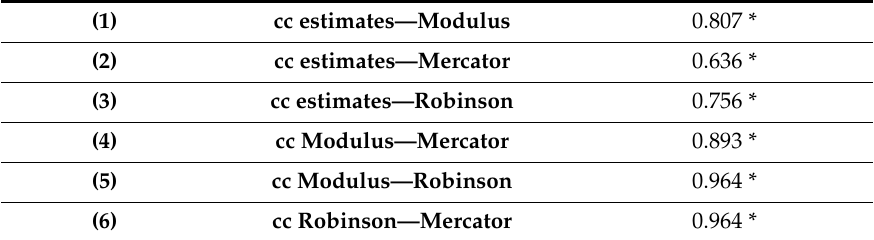
Table 3. Overview of the Pearson correlation coe ffi cients (cc) between the estimates and the true, Robinson, and Mercator areas.